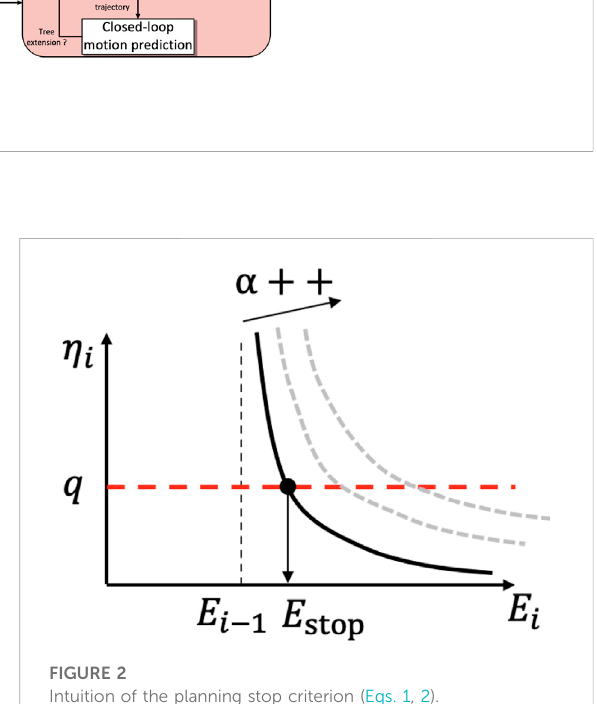
FIGURE 2 Intuition of the planning stop criterion (Eqs. 1,